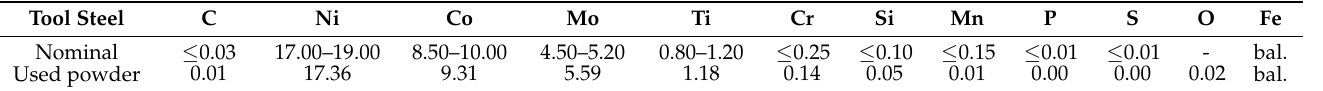
Table 1. Chemical composition of the nominal tool steel 1.2709 in mass% and the tool steel used in this work. Tool